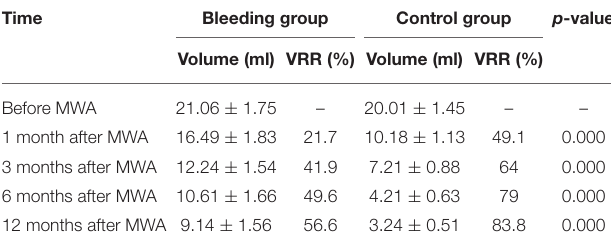
TABLE 3 | Comparison of several indicators between two groups. Bleeding group